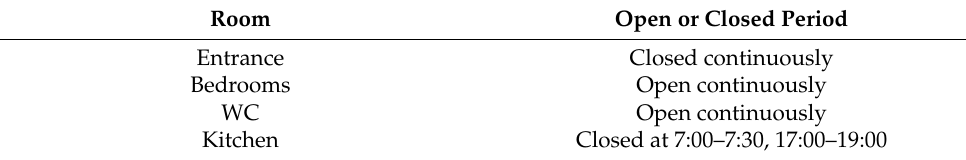
Table 7. Door open and closed times in the